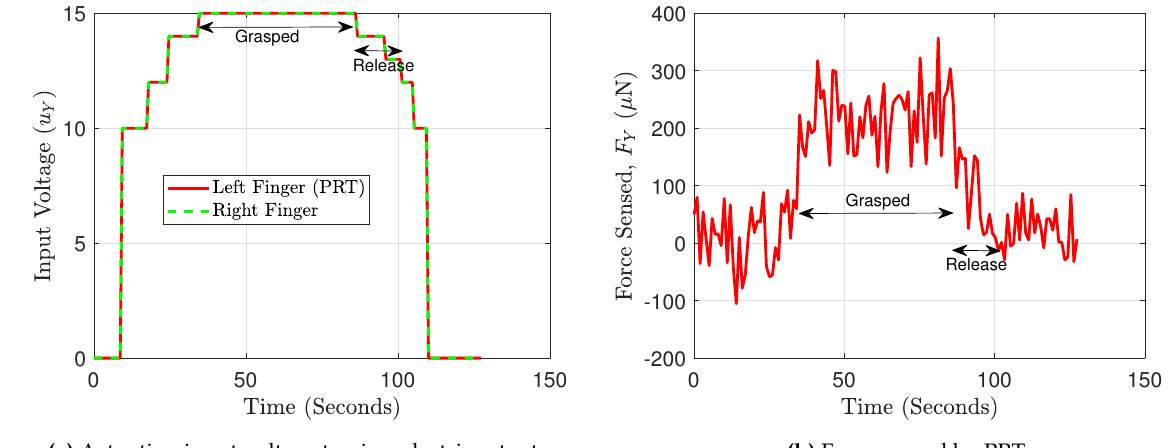
Figure 16. Grasping and release of a